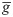
Major effects of I
A on PN response characteristics.Top panel: effects of g-
A on E1 and I duration (A) and mean firing frequency of E1 and E2 (B). Intermediate panel: effects of V
0.5act on E1 and I duration (C) and mean firing frequency of E1 and E2 phases (D). Bottom panel: effects of S
m on E1 and I duration (E) and mean firing frequency of E1 and E2 phases (F).